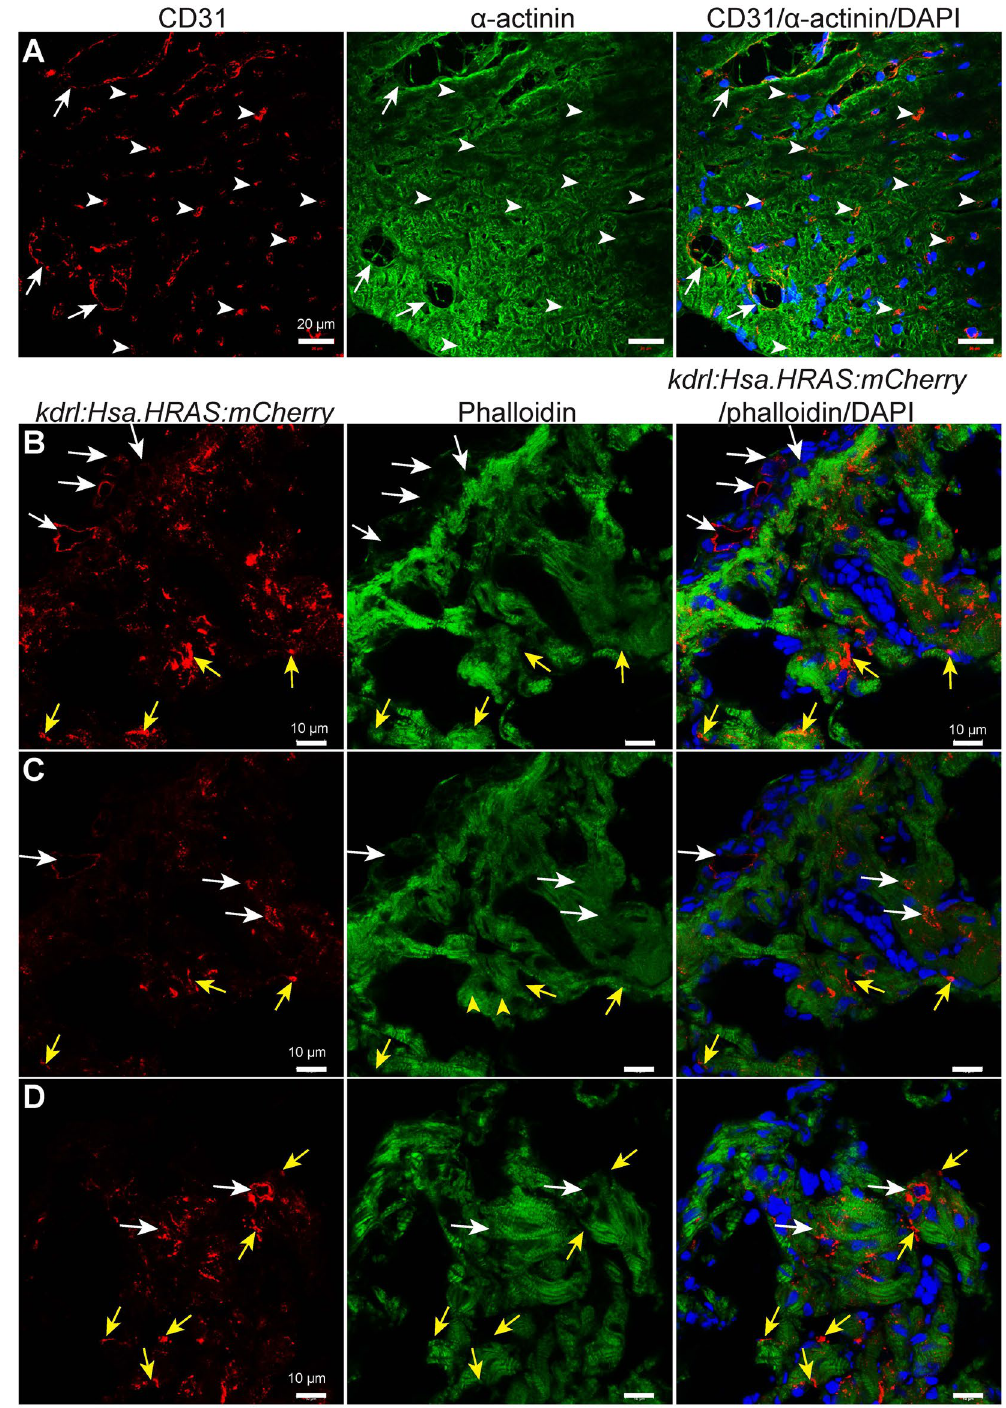
Figure 3. Endothelial cell distribution in 8 months old mouse and zebrafish ventricles. ( A ) Representative confocal images of sagittal cryosections through 8 months old mouse hearts stained for α -actinin (green; marking cardiomyocytes), CD31 (red; marking the cell membrane of endothelial cells) and DAPI (blue, staining the nuclei). White arrows and arrowheads point to bigger coronary vessels (visible lumen) and capillaries (lumen not visible) in cardiac tissue, respectively. ( B–D ) Representative confocal images of sagittal cryosections through 8 mpf Tg(kdrl:Hsa.HRAS-mCherry) zebrafish hearts stained for phalloidin (green; marking cardiac tissue), mCherry (red; marking the cell membrane of endothelial cells) and DAPI (blue; staining the nuclei). White arrows point to bigger coronary vessels (visible lumen). Yellow arrows point to endocardial cells in the cardiac tissue. ‘B’ and ‘C’ images show different optical planes of the same tissue